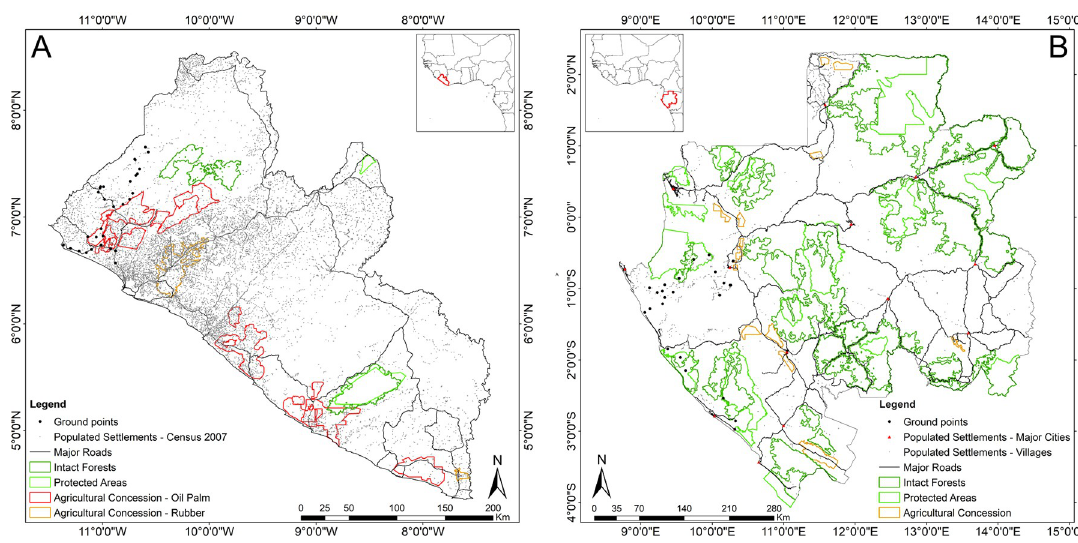
Fig 2. Geospatial datasets used as support in mapping and validation for Liberia and Gabon. Full list of datasets and their sources and references are provided in the text and Table 2.